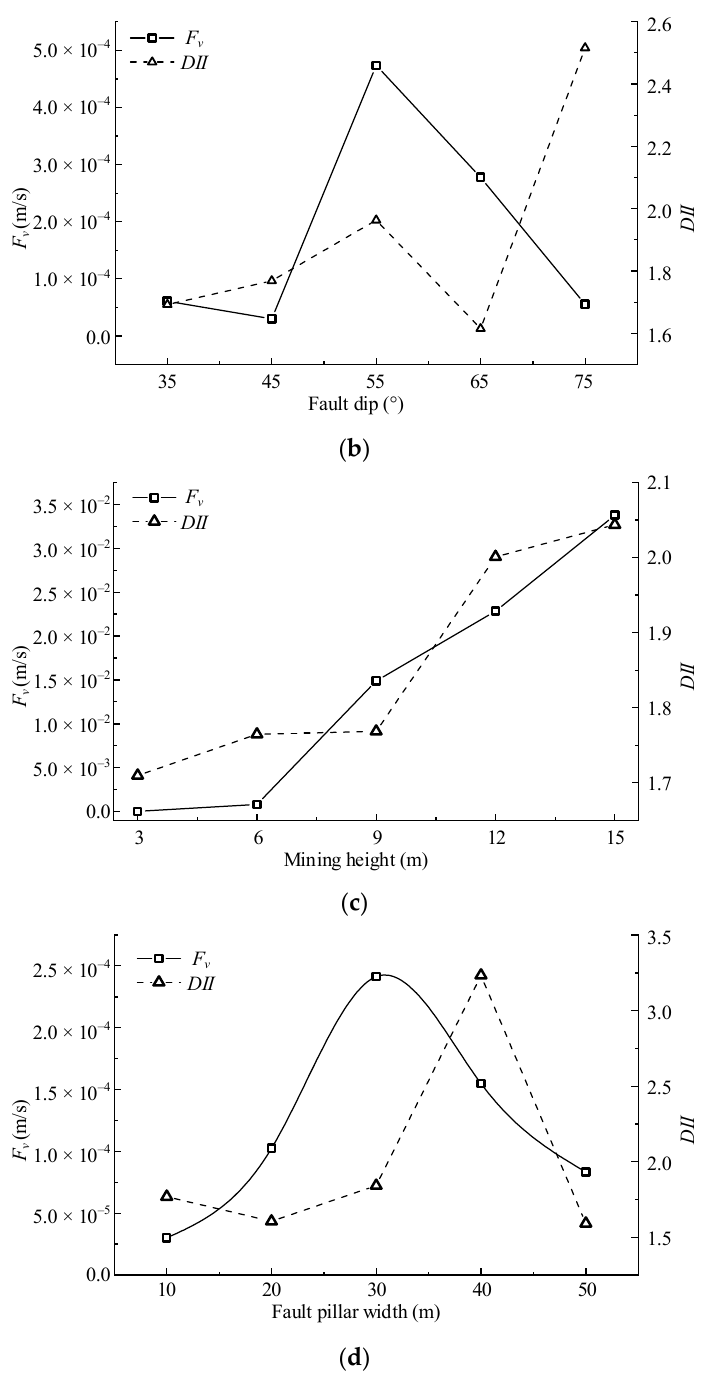
Figure 10. Change of rock burst potential under the influence of different factors based on proposed rock burst potential assessment indexes. ( a ) Influence of different fault throw on rock burst potential. ( b ) Influence of different fault dip on rock burst potential. ( c ) Influence of different mining height on rock burst potential. ( d ) Influence of different fault pillar width on rock burst potential.